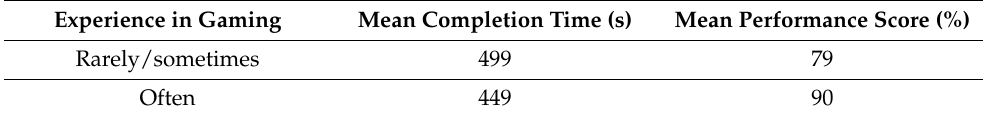
Table 2. Comparison of the quiz completion time between the developed VR training